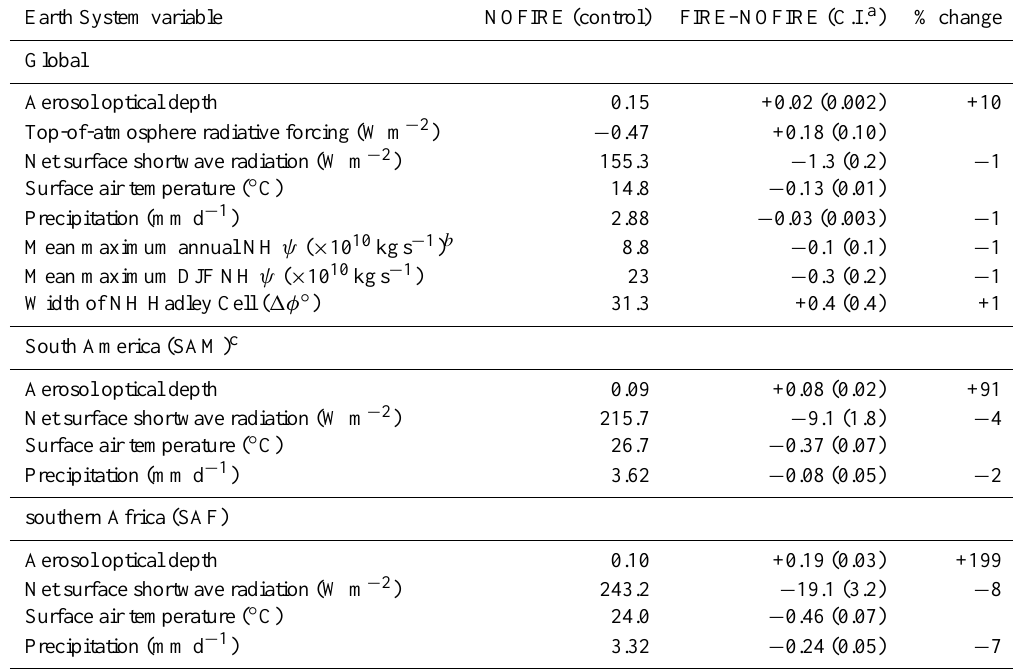
Table 4. Summary of the simulated global climate response to fire aerosols. Earth System variable